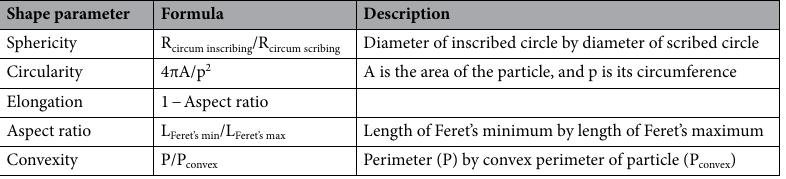
Table 1. Table of shape parameters used in the study.